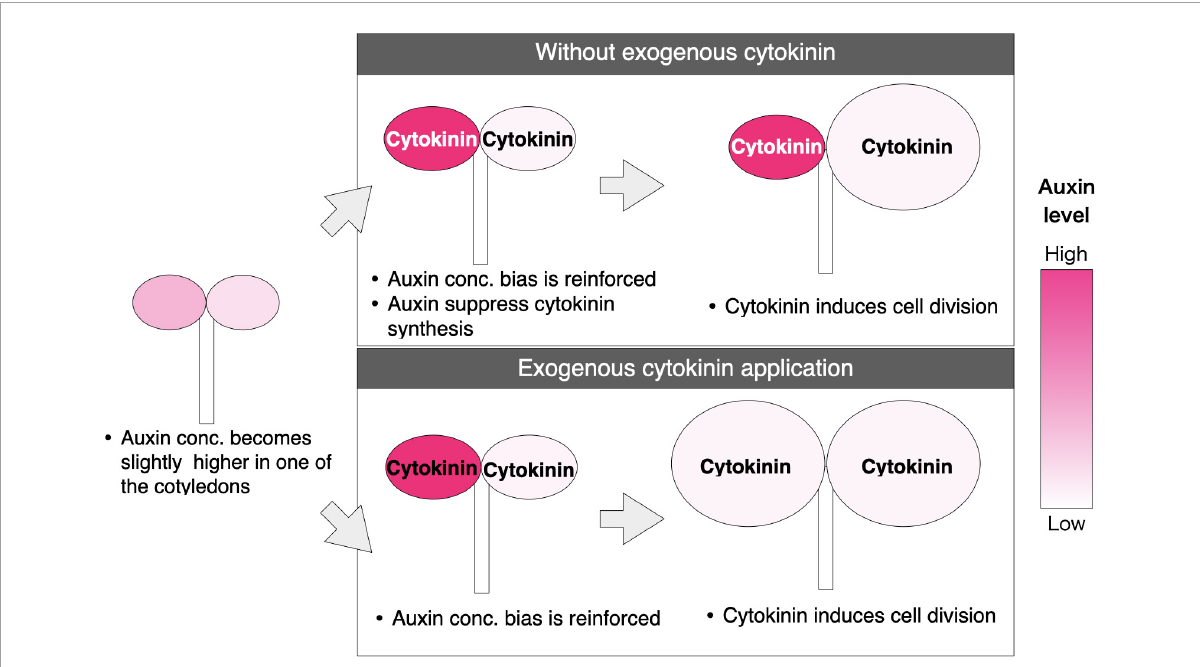
FIGURE7 Proposed model for fate determination of the two cotyledons in M. glabra . The red color indicates the concentration of auxin. The darker color indicates higher concentration. The black and white color of the letters, “Cytokinin” indicates the high and low concentration of cytokinin in the cotyledons, respectively. The developmental process indicated in the upper part is under a non-treated condition; auxin concentration is slightly different between the two cotyledons in the isocotylous stage. After some time, the difference of the auxin level is enforced due to “up-the-gradient” mechanisms supported by auxin polar transport. Then, cytokinin is produced less in the cotyledon where the auxin level is higher due to the inhibition of cytokinin synthesis by auxin signaling. This results in only one of the cotyledons with a higher cytokinin level becoming a macrocotyledon. The diagram on the bottom shows a developmental process where cytokinin is applied exogenously; when the cytokinin level exceeds a certain threshold in both cotyledons, regardless of the auxin level, both cotyledons can become